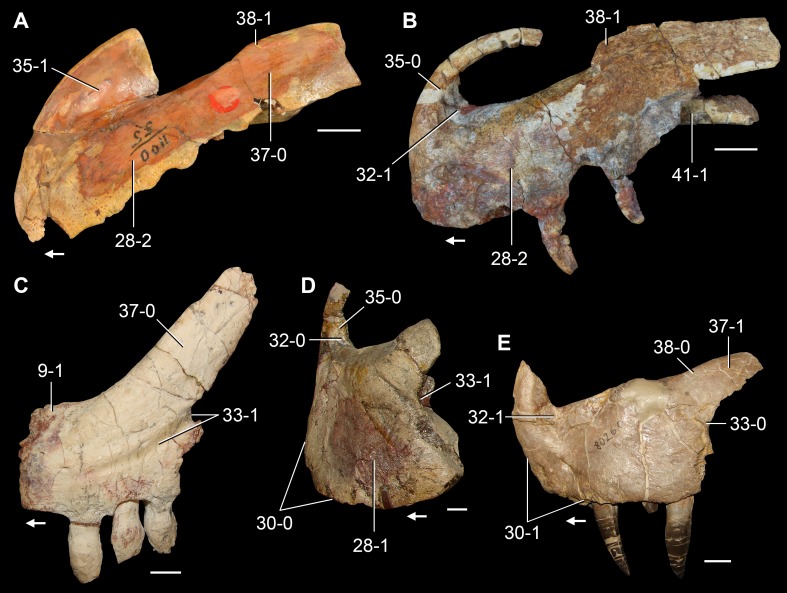
Left (A, D, E) and right (B, C) premaxillae of Permo-Triassic archosauromorphs in lateral view.(A) Archosaurus rossicus (PIN 1100/55); (B) Sarmatosuchus otschevi (PIN 2865/68-9, mirrored); (C) Azendohsaurus madagaskarensis (UA 8-7-98-284, mirrored); (D) Shansisuchus shansisuchus (IVPP V2505); and (E) Batrachotomus kupferzellensis (SMNS 80260). Numbers indicate character-states scored in the data matrix and the arrows indicate anterior direction. Scale bars equal 1 cm in (A, B, D, E) and 5 mm in (C).